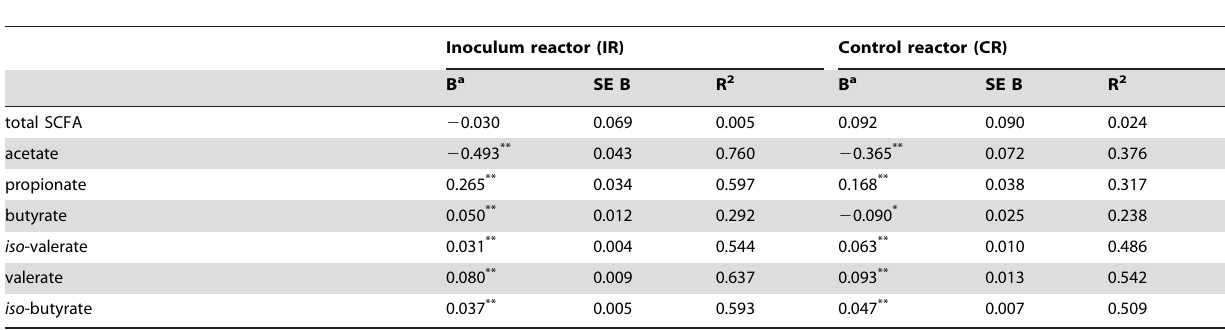
Table 2. Effect of culture time on metabolite concentrations analyzed by linear regression